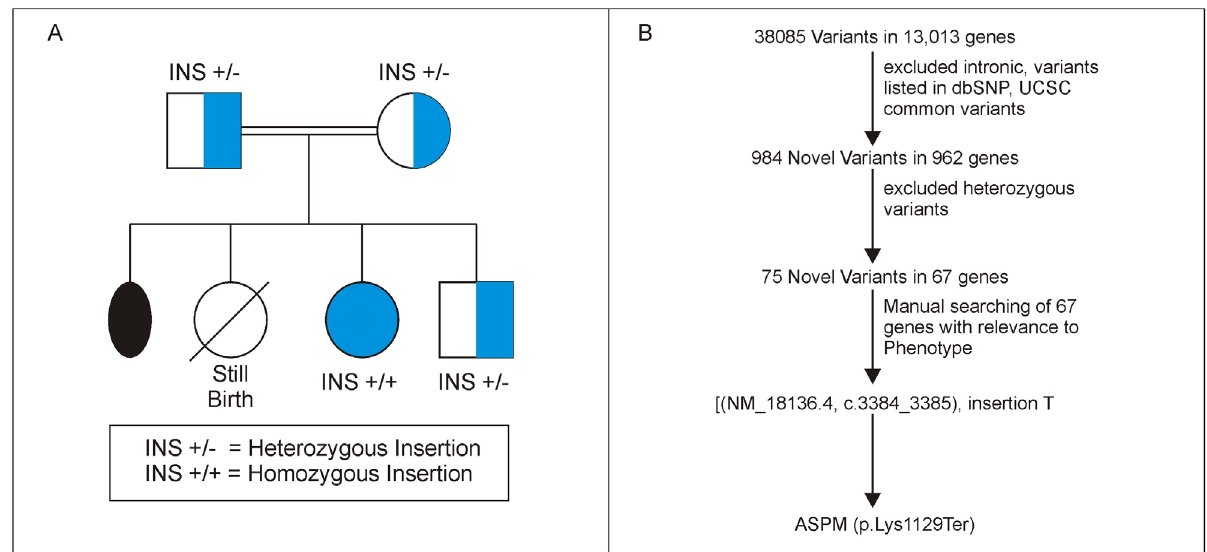
Figure 1. ( A ) The pedigree of the family; ( B ) workflow of the variant